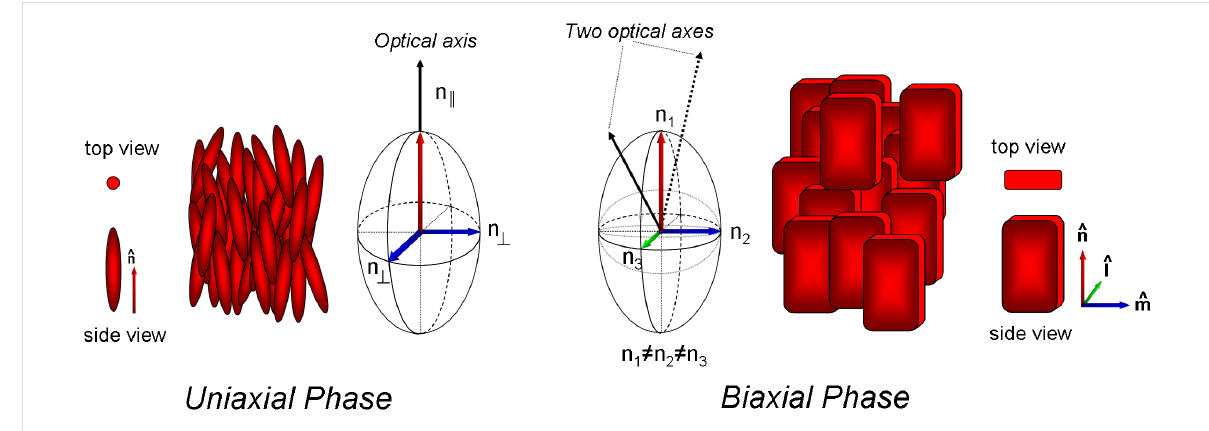
Figure 1: Uniaxial nematic (left) and biaxial nematic (right) phases and their corresponding indicatrices.